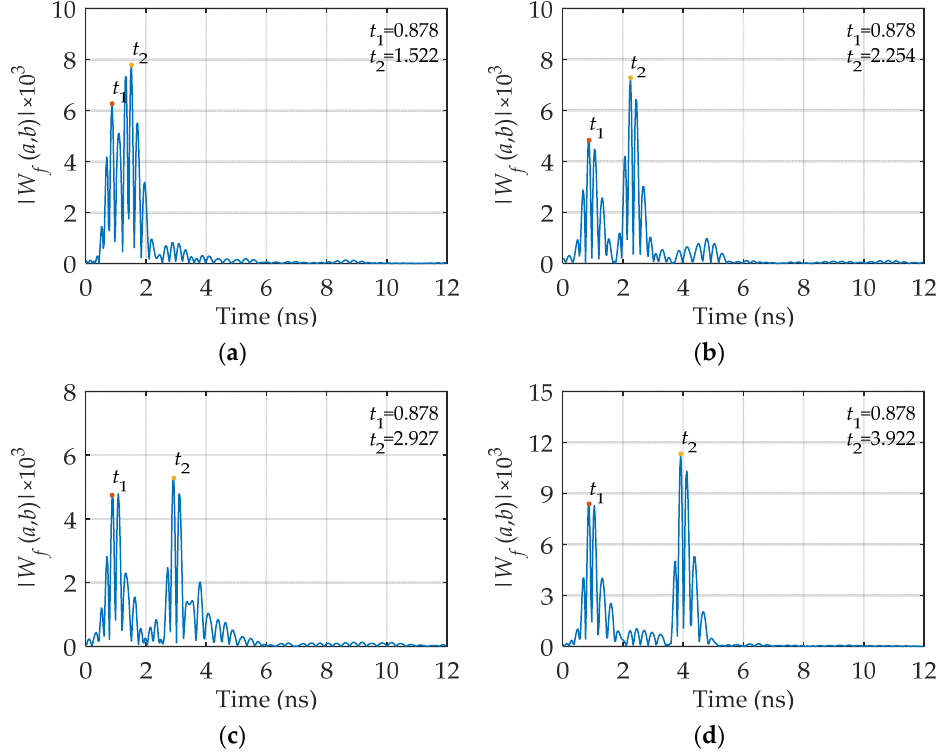
Figure 16. Modules curves of wavelet transform coefficients obtained by using db5 wavelet basis for typical single-channel signals ( a = 10): ( a ) survey line y 2 ; ( b ) survey line y 5 ; ( c ) survey line y 8 ; ( d ) survey line y 11 .